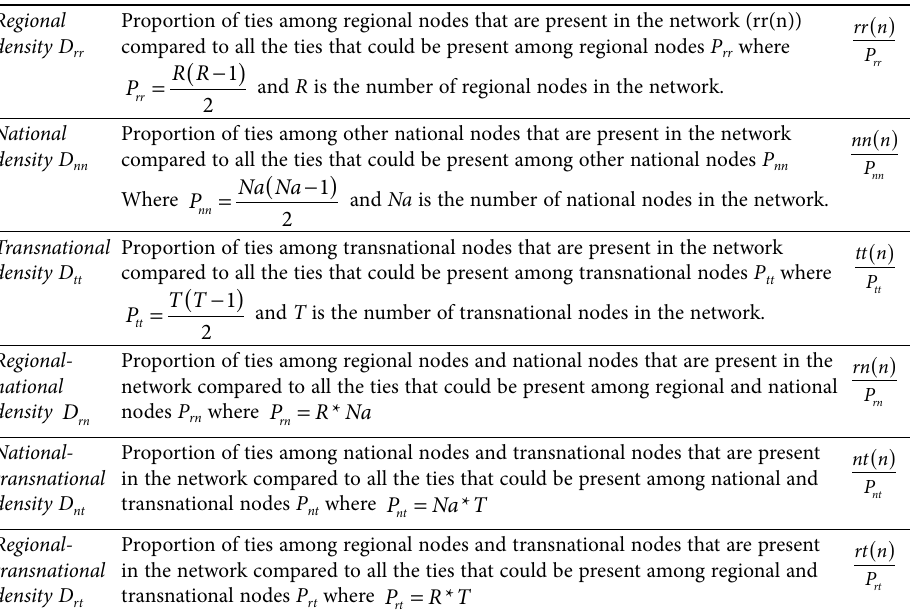
Table 3. Density for specific types of relations. Regional